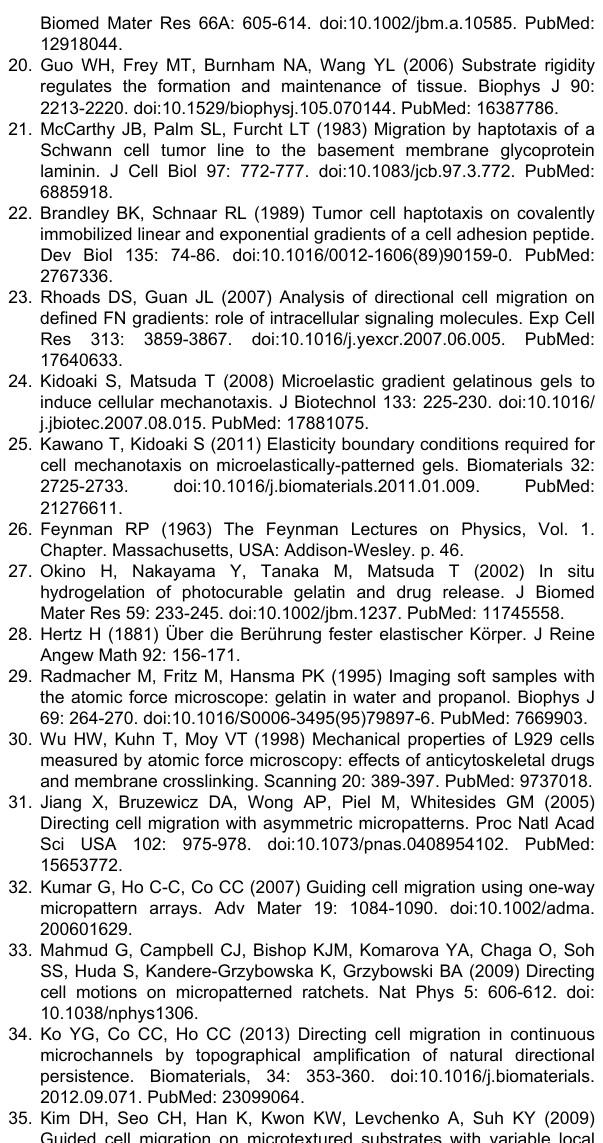
Figure S1. Migration responses of different type of cell on the saw-like micro-elastically patterned gels. Smooth muscle cells (rabit, primary) and human mesenchymal stem cells (purchased from Ronza) were cultured for 24hr on the gels of A1 condition, and compared with the behaviors of 3T3 fibroblasts. Observed cell trajectories are shown.